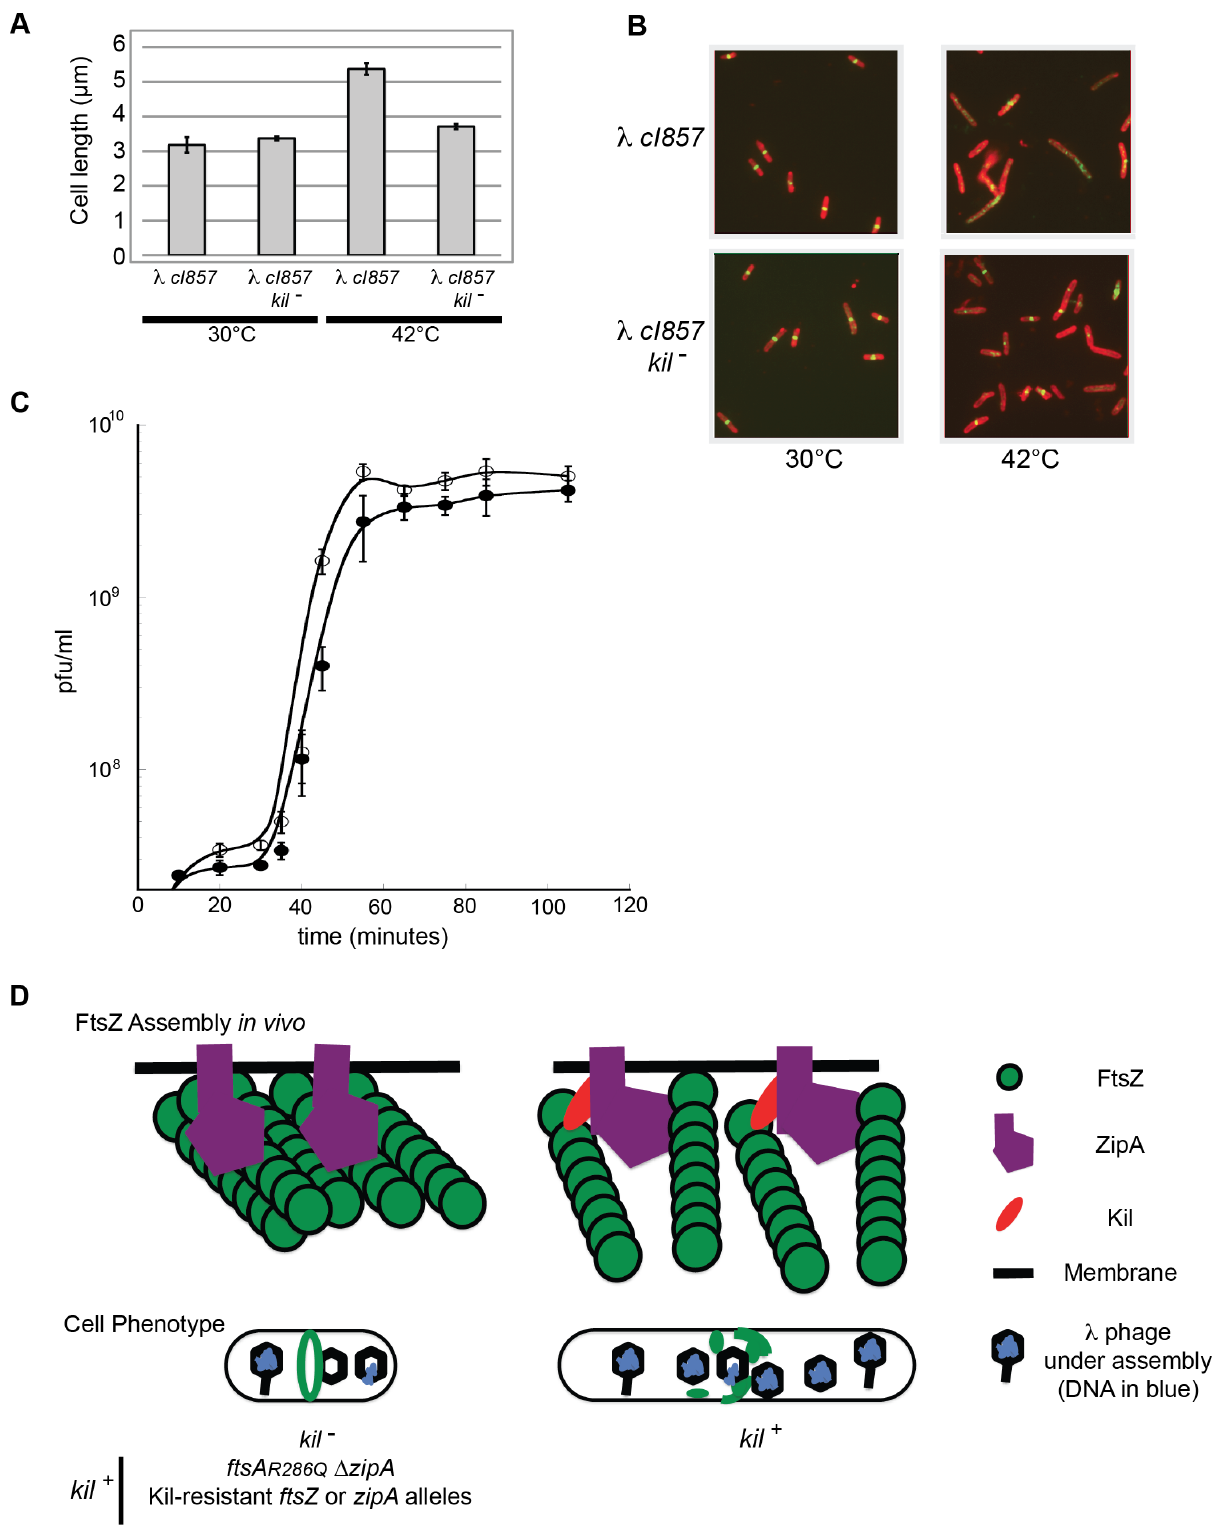
Figure 9. l lysogen induction inhibits host cell division in a kil -dependent manner. (A) Induction of a l lysogen results in a kil -dependent increase in E. coli cell length prior to host cell lysis. The average fixed-cell lengths of indicated kil + and kil 2 strain populations 40 minutes post l lysogen induction (42 u C), or control non-inducing conditions (30 u C) are plotted. Error bars represent standard deviation between three separate population measurements. (B) Induction of a l lysogen results in a kil -dependent, near-total ablation of FtsZ rings prior to host lysis. Representative IFM micrographs stained for cell wall (red) and a -FtsZ (green) are shown from the same fixed cells used for (A); the indicated genotypes and growth